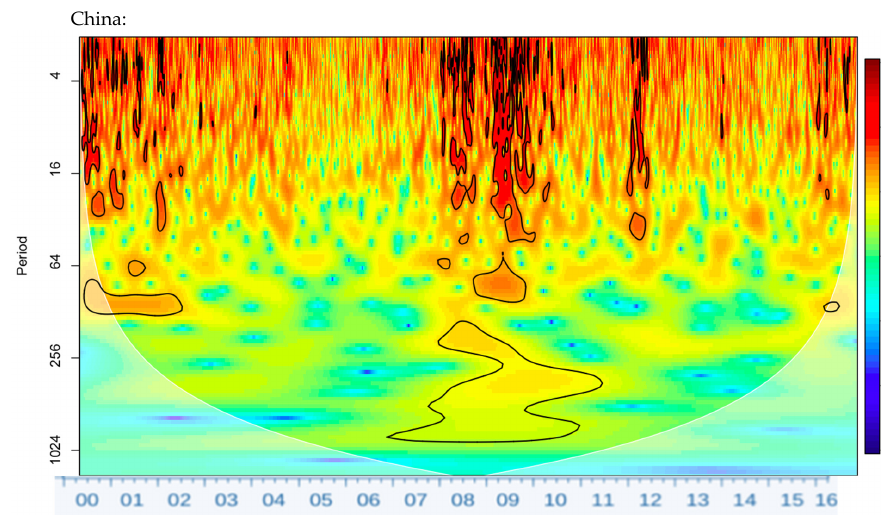
Figure 2. Wavelet Power Spectrum for Europe, Japan, Brazil, Russia, India and China. The most interesting volatility bouts in this study are in fact those originating from emerging markets, in particular China. The 2015 Chinese stock market crash and the 2016 circuit break are isolated and highlighted by white dashed lines. These periods of volatil- ity are highly significant in the advanced stock markets. This result implies that spillovers between the BRICs’ and the advanced economies’ markets are becoming increasingly bi- directional and that the BRIC markets have now reached both depth and scale that enables BRIC economies to originate contagion to the advanced economies. Since the GFC, China and Brazil appear to be more integrated in the global financial system in terms of signifi- cant shared bouts of volatility. However, China acted as a potential strong diversifier to